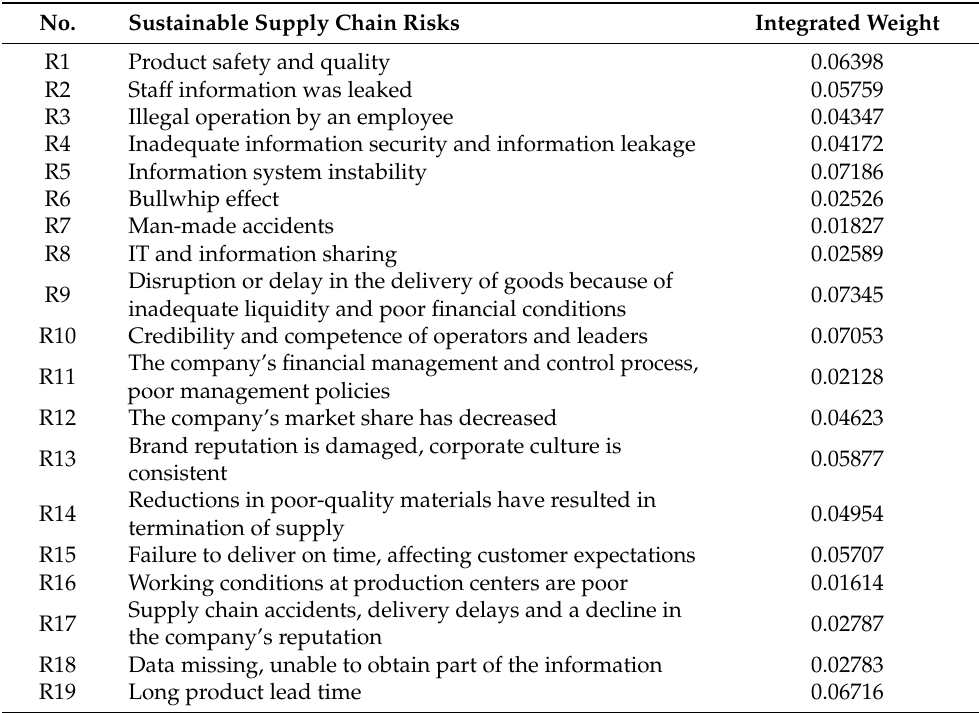
Table 17. Integrated weights of key